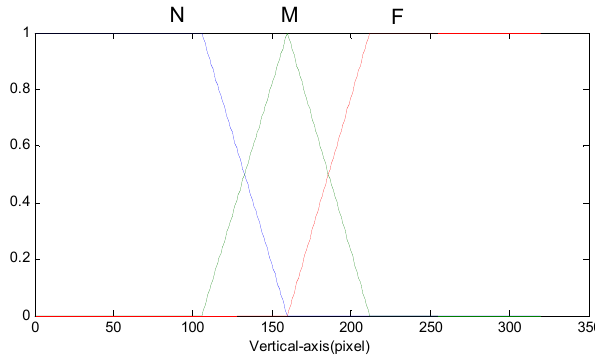
Figure 7. Membership functions of the horizontal position of a moving target in an image frame. Appl. Sci. 2016, 6, 82